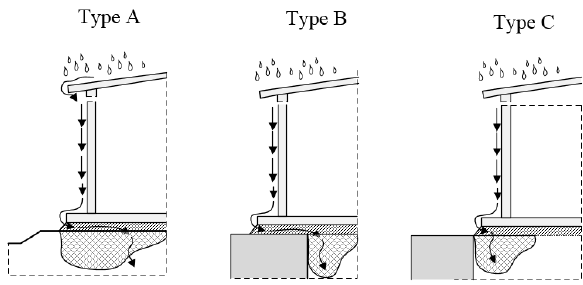
Figure 2: Chosen cases of settlement of cylindrical tanks [3]: a) in the form of a trough, b) circumferential trough near or far from the shell, c) local trough near the shell